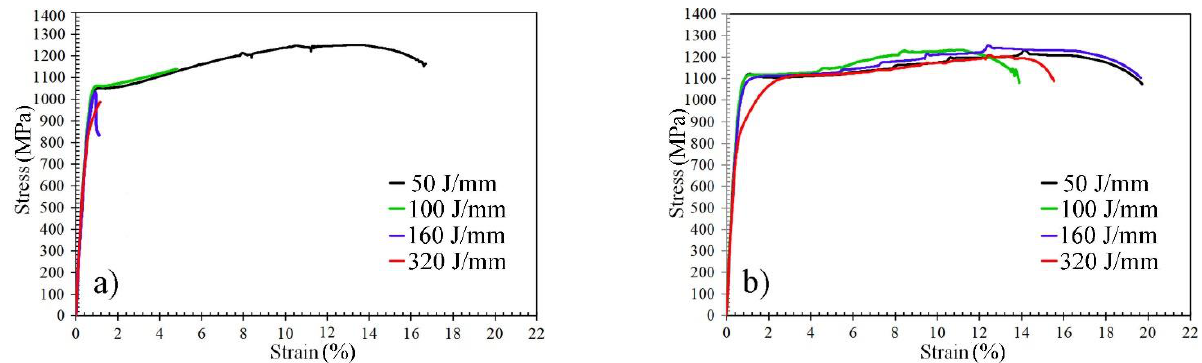
Figure 12. Typical engineering strain – stress curves of the dissimilar butt joints ASS/AR600 with different EIs: ( a ) as-welded; ( b ) with post-weld heat treatment at 250 °C for 1 h.